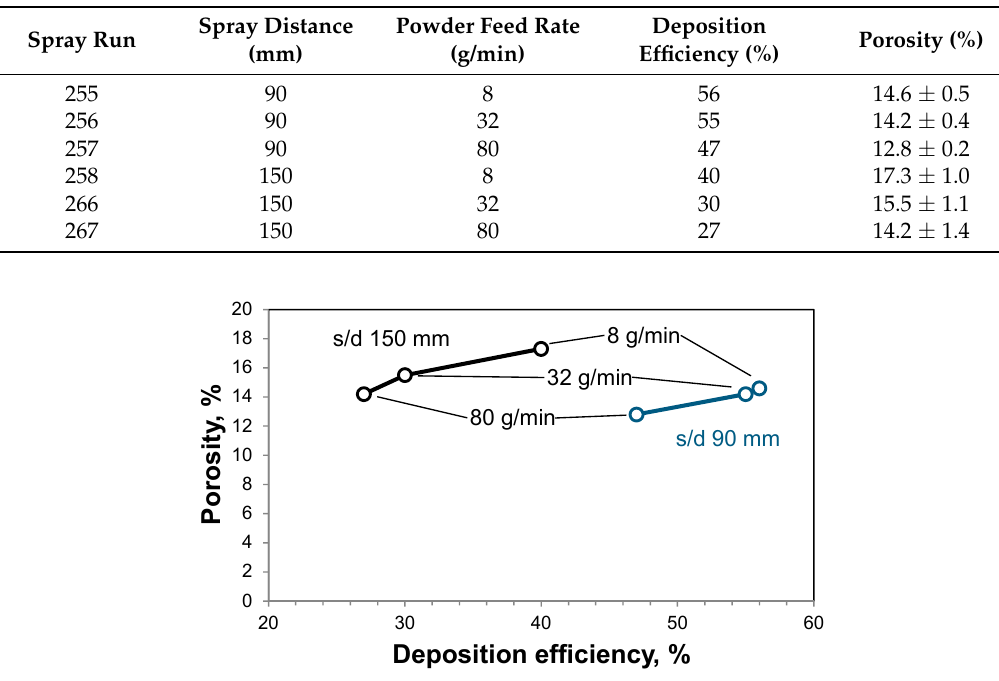
Table 4. Effect of spray distances and powder feed rates on deposition efficiencies and coating porosities (TriplexPro™-210 at low power with Ar–He plasma gas mixture (22 kW), powder 321 M); porosities averaged from three images.